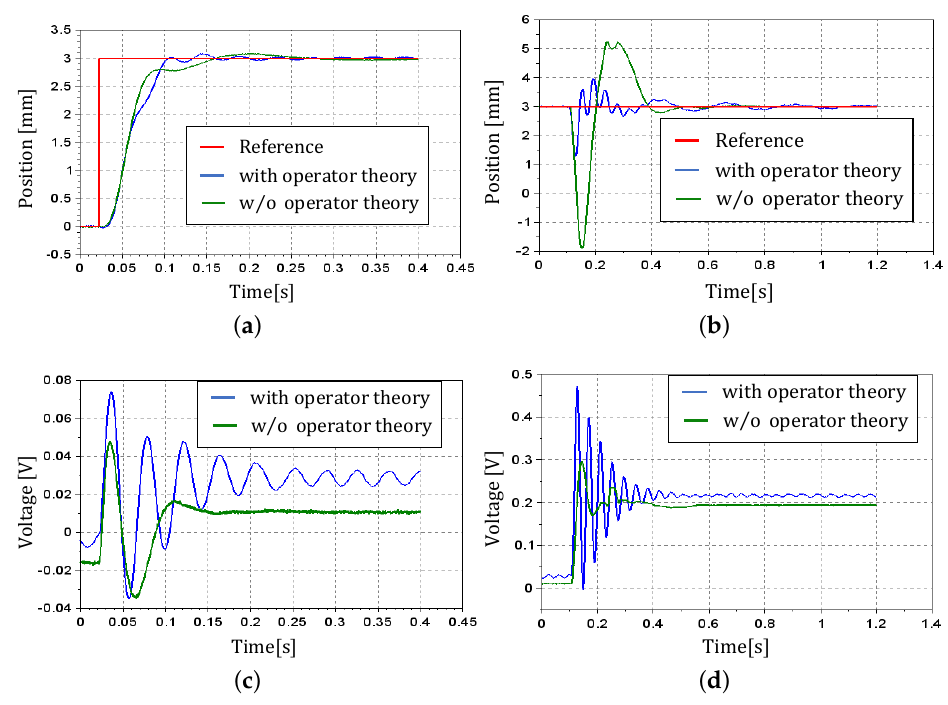
Figure 15. Experimental results with DOB. ( a ) Position of stage for reference. ( b ) Position of stage for disturbance. ( c ) Input voltage for reference. ( d ) Input voltage for disturbance.